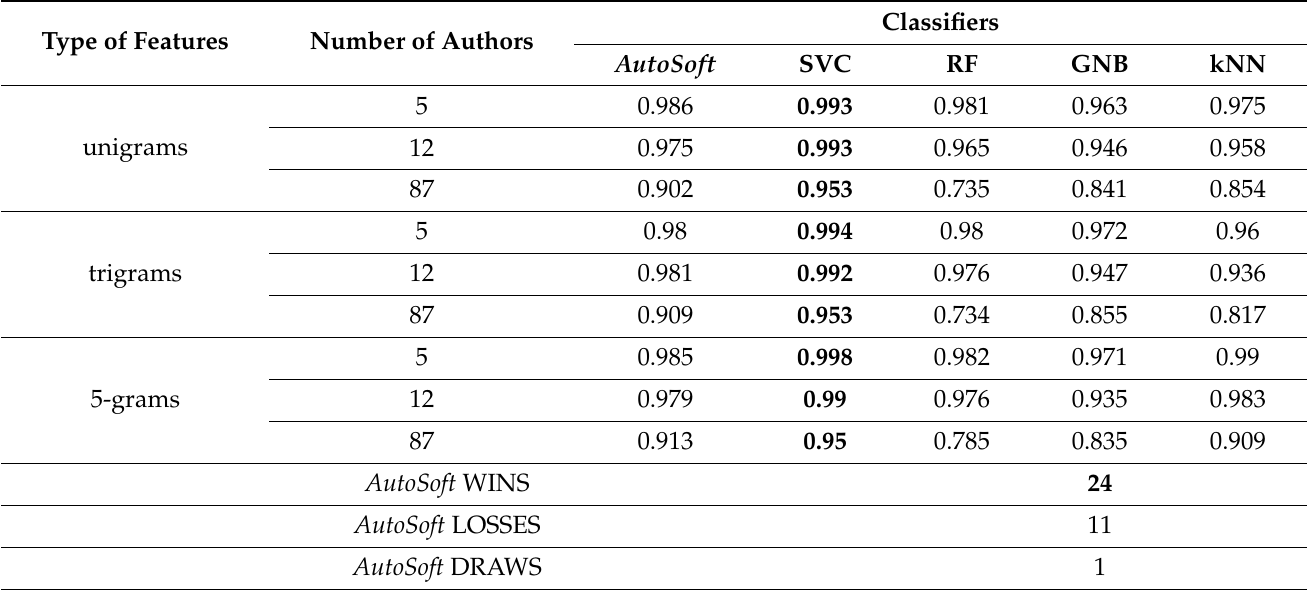
Table 3. Comparison between AutoSoft and classifiers from the literature in terms of F 1 -score , WINS, LOSSES and